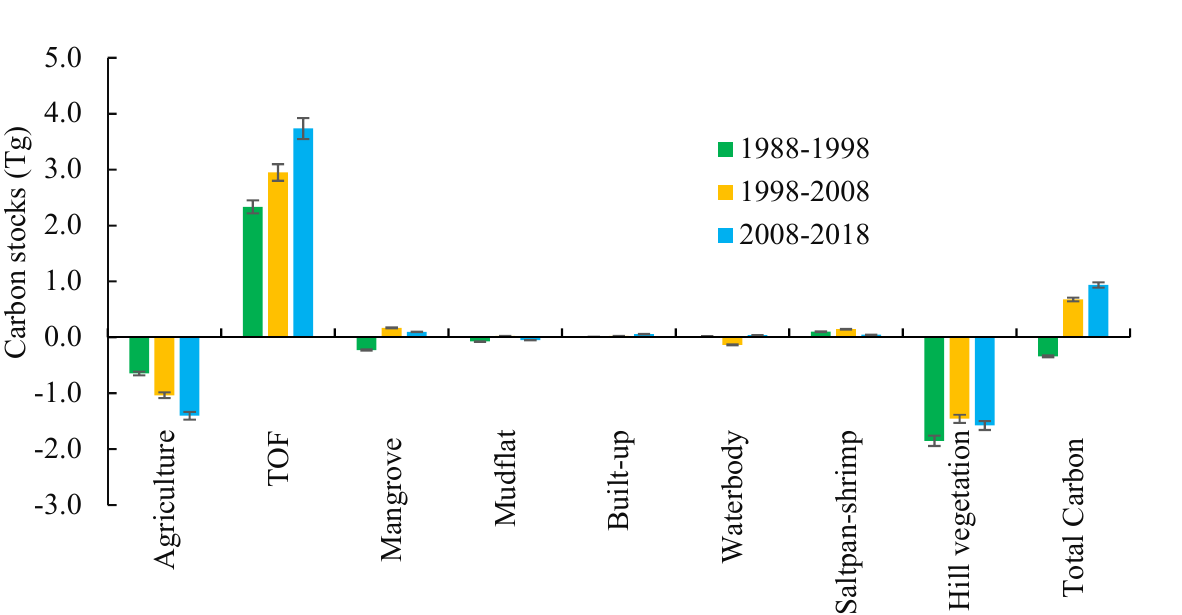
Figure 7. Carbon sequestration by different LULC over the period 1988–2018.